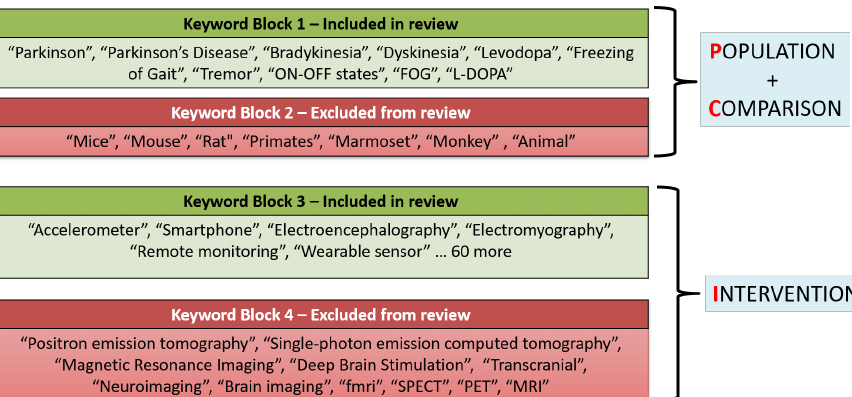
Figure 3. Keyword blocks constructed according to the PICO strategy to determine the relevance of an article to this